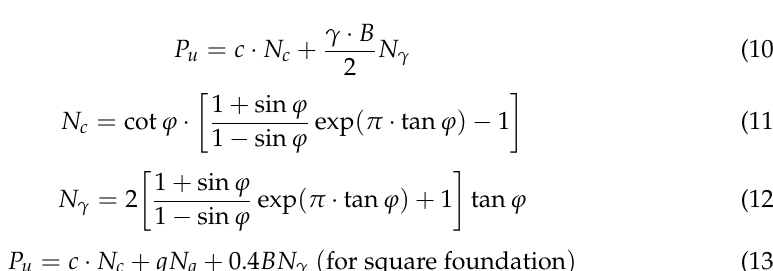
Table 1. Parameters and values for numerical analysis.